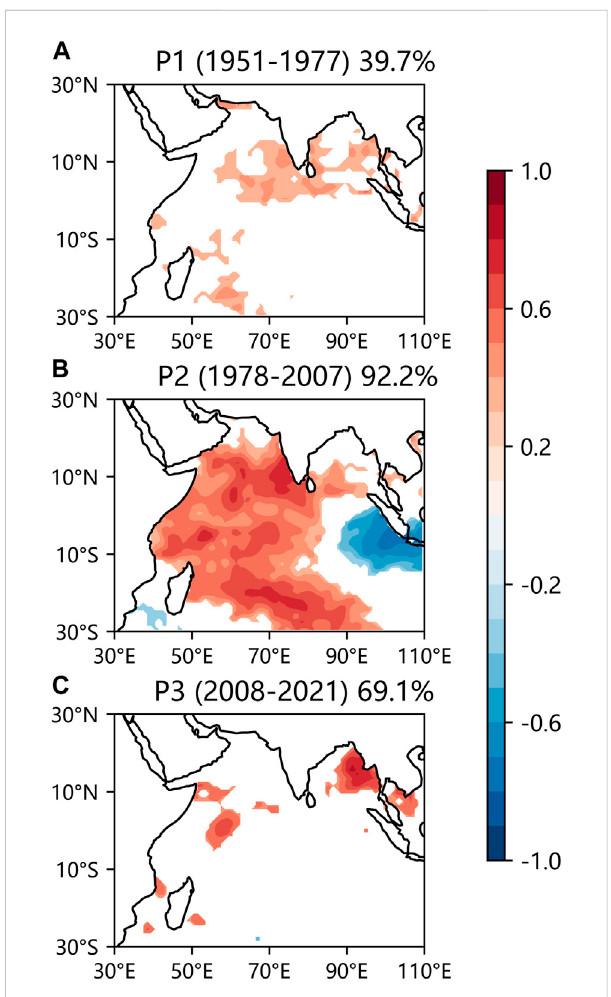
FIGURE 4 The correlation coef fi cient of the previous autumn Indian Ocean SSTA with the right- fi eld time series of SVD-PC1 during. (A) P1, (B) P2, and (C) P3. The left fi eld used for SVD is: SSTA in the TIO (30 ° S – 30 ° N, 30 ° E – 110 ° E) in the previous autumn; The right fi eld is: the 850 hPa wind fi eld anomalies in the summer of the South China Sea (5 ° N – 20 ° N, 105 ° E – 120 ° E), only showing the area that passed the 90% signi fi cance test (Figures 6 – 10 is also the